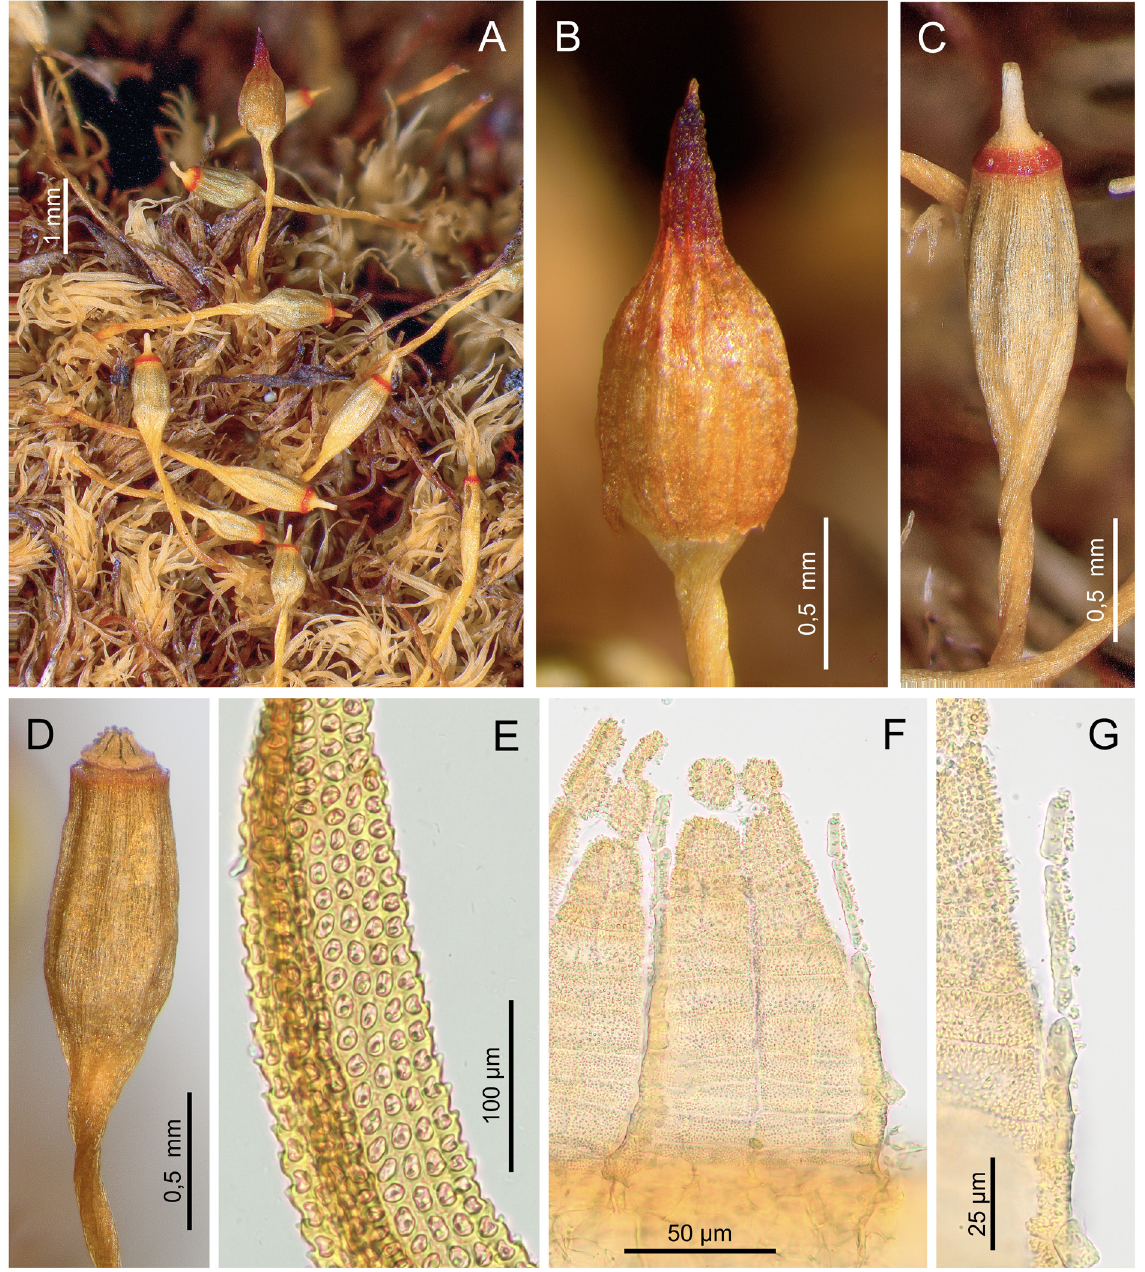
Fig. 3. Ulota glabella Mitt. Details from the epitype ( R. Garilleti 2012-077A ). A . Habit with operculate capsules. B . Calyptra. C . Operculate capsule, note the broad red basal ring of the lid. D . Capsule immediately after detachment of the lid. E . Crenulate-serrate leaf margin. F . Peristome. G . Detail of the endostome ornamentation. Photographs by R.